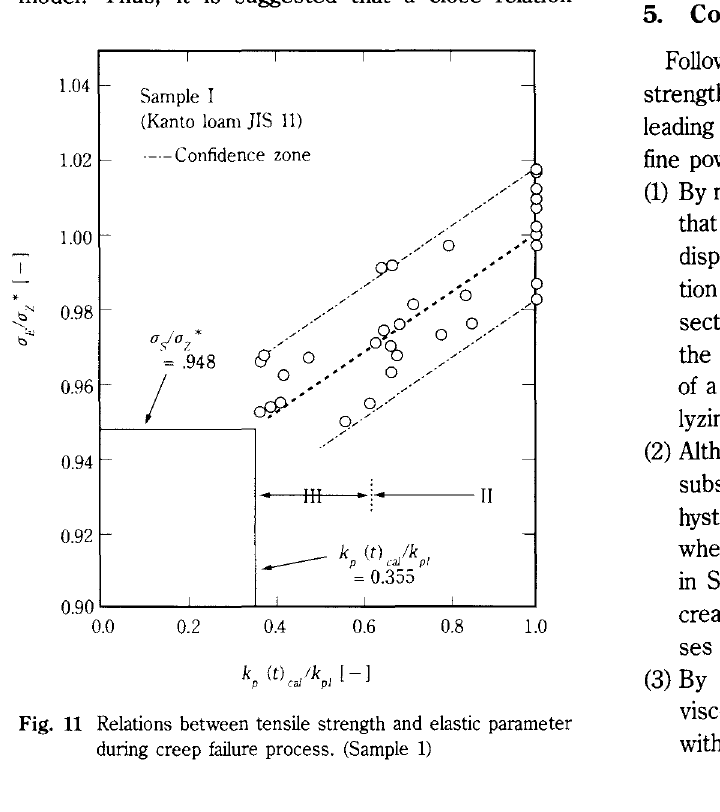
Fig. 11 Relations between tensile strength and elastic parameter during creep failure process. (Sample 1)